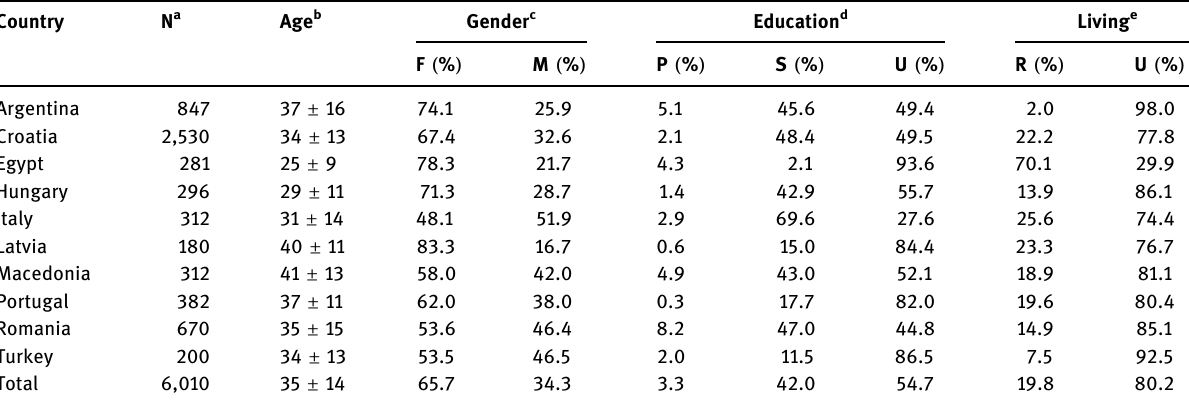
Table 2: Characterization of participants by country